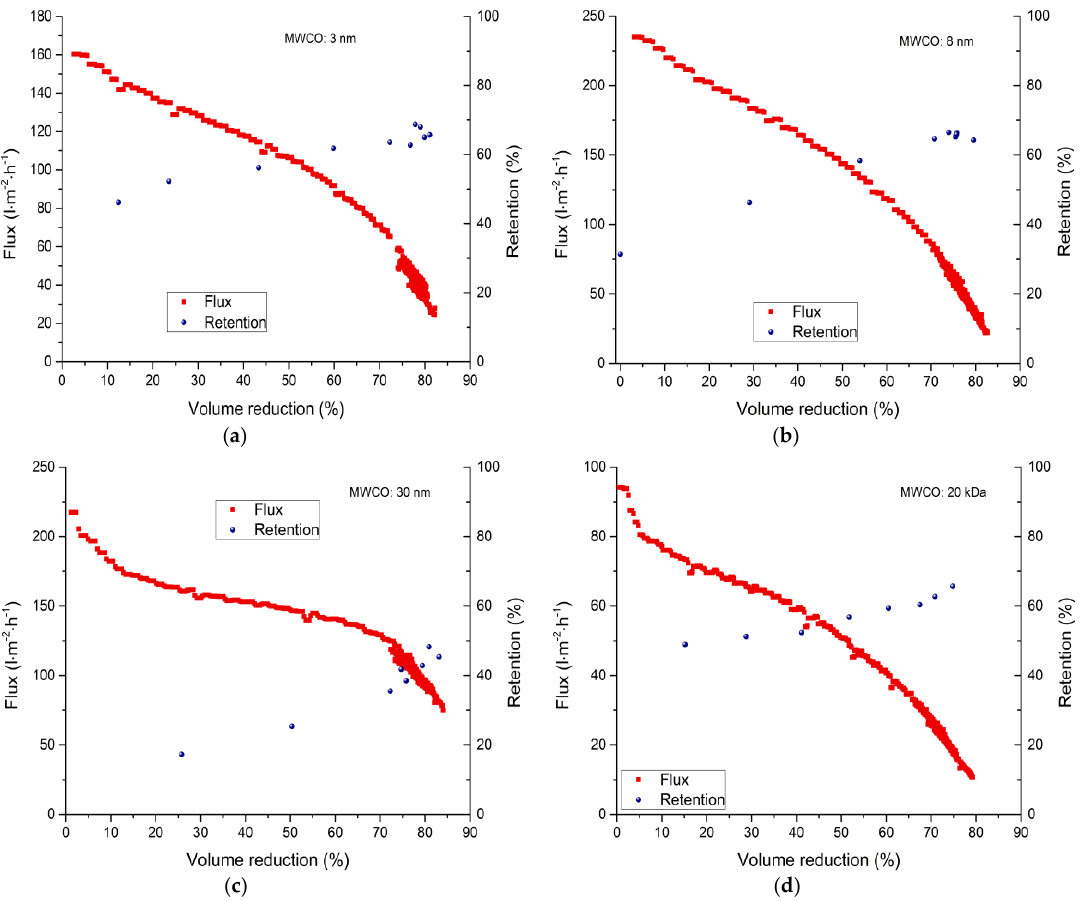
Figure 4. Flux loss and lignosulfonate retention depends on volume reduction during the filtration of spent sulfite liquor. ( a ) 3-nm ceramic hollow fiber membrane. ( b ) 8-nm ceramic hollow fiber membrane. ( c ) 30-nm ceramic hollow fiber membrane. ( d ) 20-kDa ceramic tubular membrane. Process parameters: Re = 12,720, transmembrane pressure = 3 bar, and temperature = 60 °C.